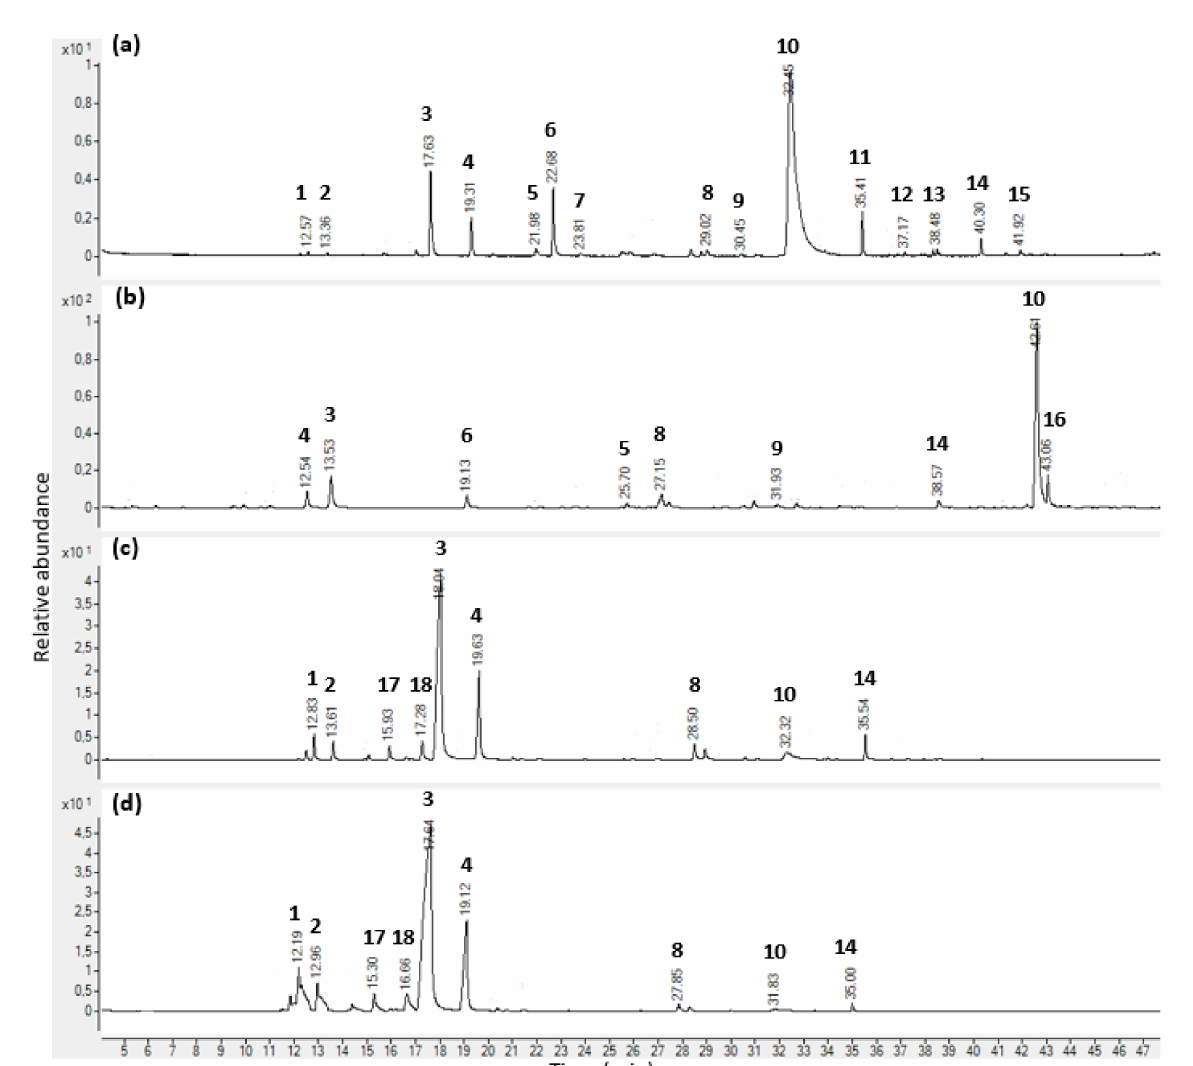
Figure 1. GC-MS chromatograms of Thymus vulgaris L. essential oil obtained from commercial source C and headspace analysis of its vapour. ( a ) Chromatogram on an HP-5MS column; ( b ) chromatogram on a DB-HeavyWAX column; ( c ) chromatogram of the headspace after a 9-h incubation period using solid-phase microextraction sampling technique; ( d ) chromatogram of the headspace after a 9-h incubation period using gas tight syringe sampling technique. Peak number and compound names: 1. α -pinene, 2. camphene, 3. p -cymene, 4. γ -terpinene, 5. linalool, 6. methyl octanoate, 7. Camphor, 8. Thymol methyl ether, 9. Carvone, 10. thymol. 11. β -caryophyllene, 12. γ -Muurolene, 13. δ -cadinene, 14. caryophyllene oxide, 15. α -epi-cadinol, 16. Carvacrol, 17. β -myrcene, 18. α